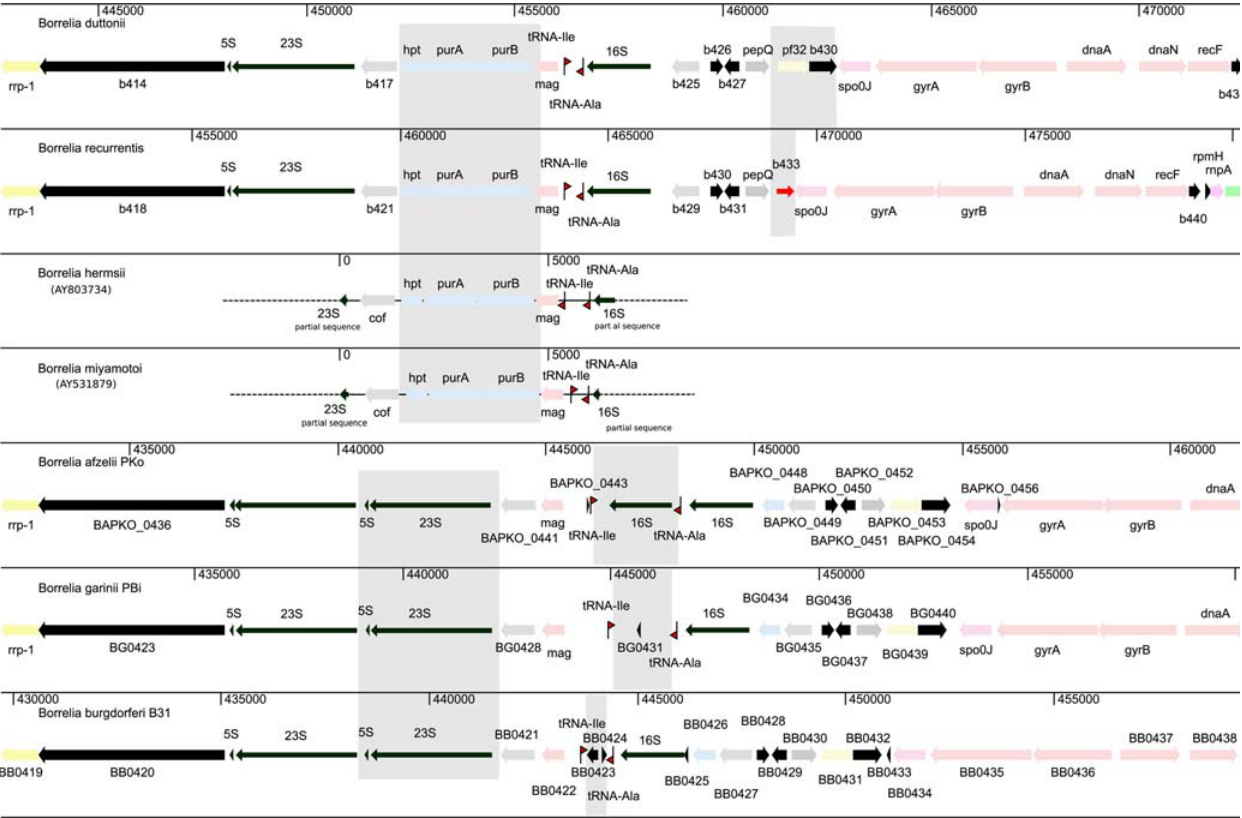
Figure 1. Genomic region around the chromosomal origin of replication in B.recurrentis , B.duttonii , B.hermsii , B.miyamotoi , B. burgdorferi , B.garinii , and B.afzelii . Insertion of hpt , pur A, and pur B is specific to the recurrent fever group borreliae. Duplication of 5S–23S rDNA is specific to the Lyme disease group borreliae. Variable spacing was observed between the Ala and Ile tRNAs. Specific degradation in the 5 9 genomic region of spo0 J was observed in B. recurrentis . Genes are colored according to their predicted functional category (Figure S1). Shaded areas correspond to regions of difference.